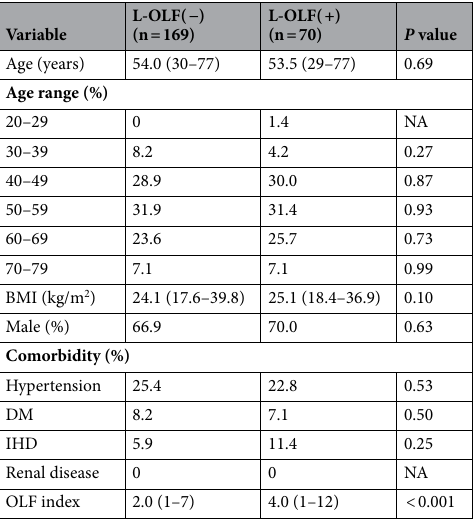
Table 2. Comparison of clinical characteristics between subjects with or without lumbar OLF. Data are shown as median (minimum–maximum) or as percentage. BMI body mass index, OLF ossification of the ligamentum flavum, L lumbar, DM diabetes mellitus, IHD ischemic heart disease, NA not available.